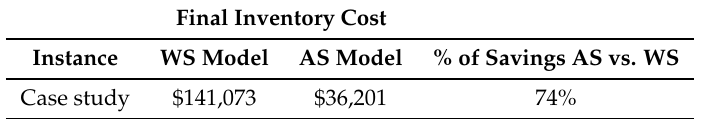
Table 11. Comparison between the final inventory cost for the AS and WS model for the case study